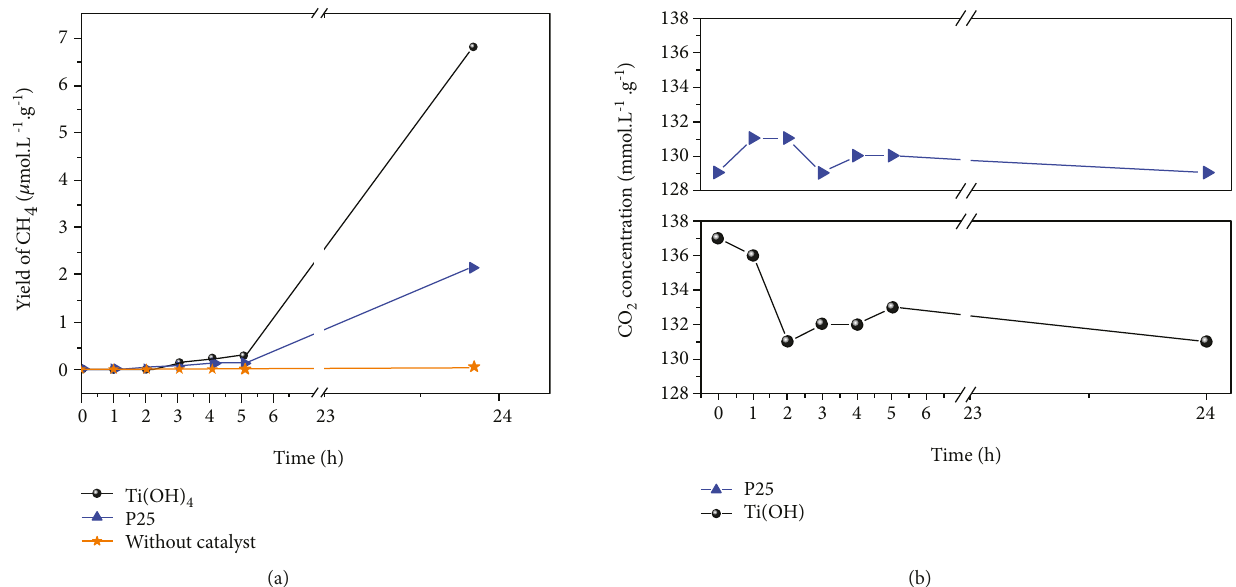
Figure 10: (a) CO photoreduction kinetics and (b) CO 2